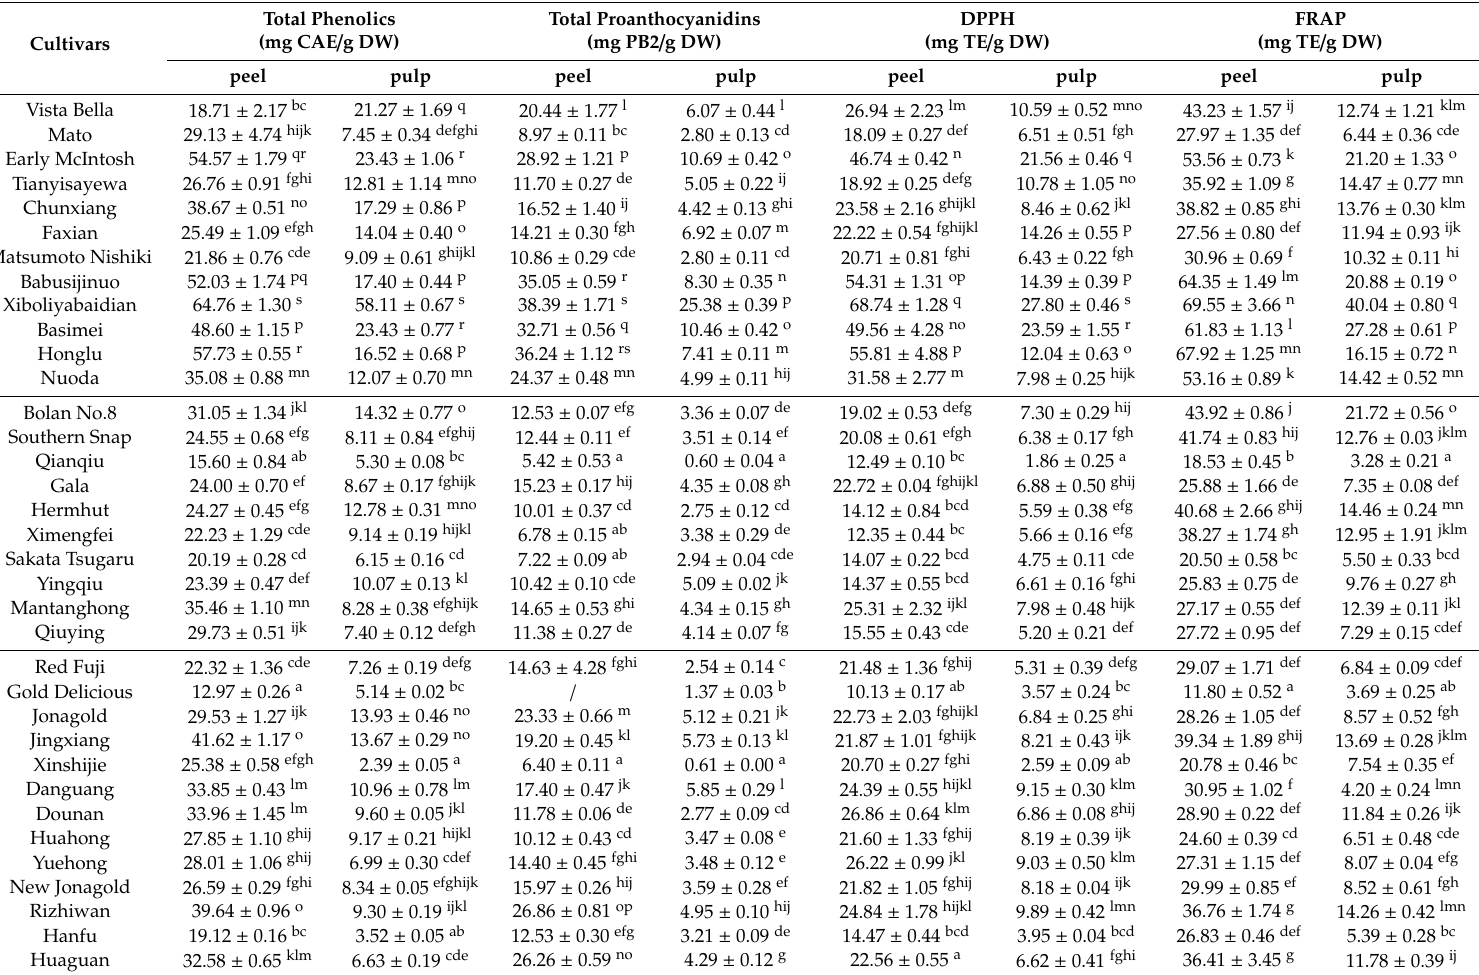
Table 2. Total phenolics, total proanthocyanidins, and antioxidant activities of di ff erent apple